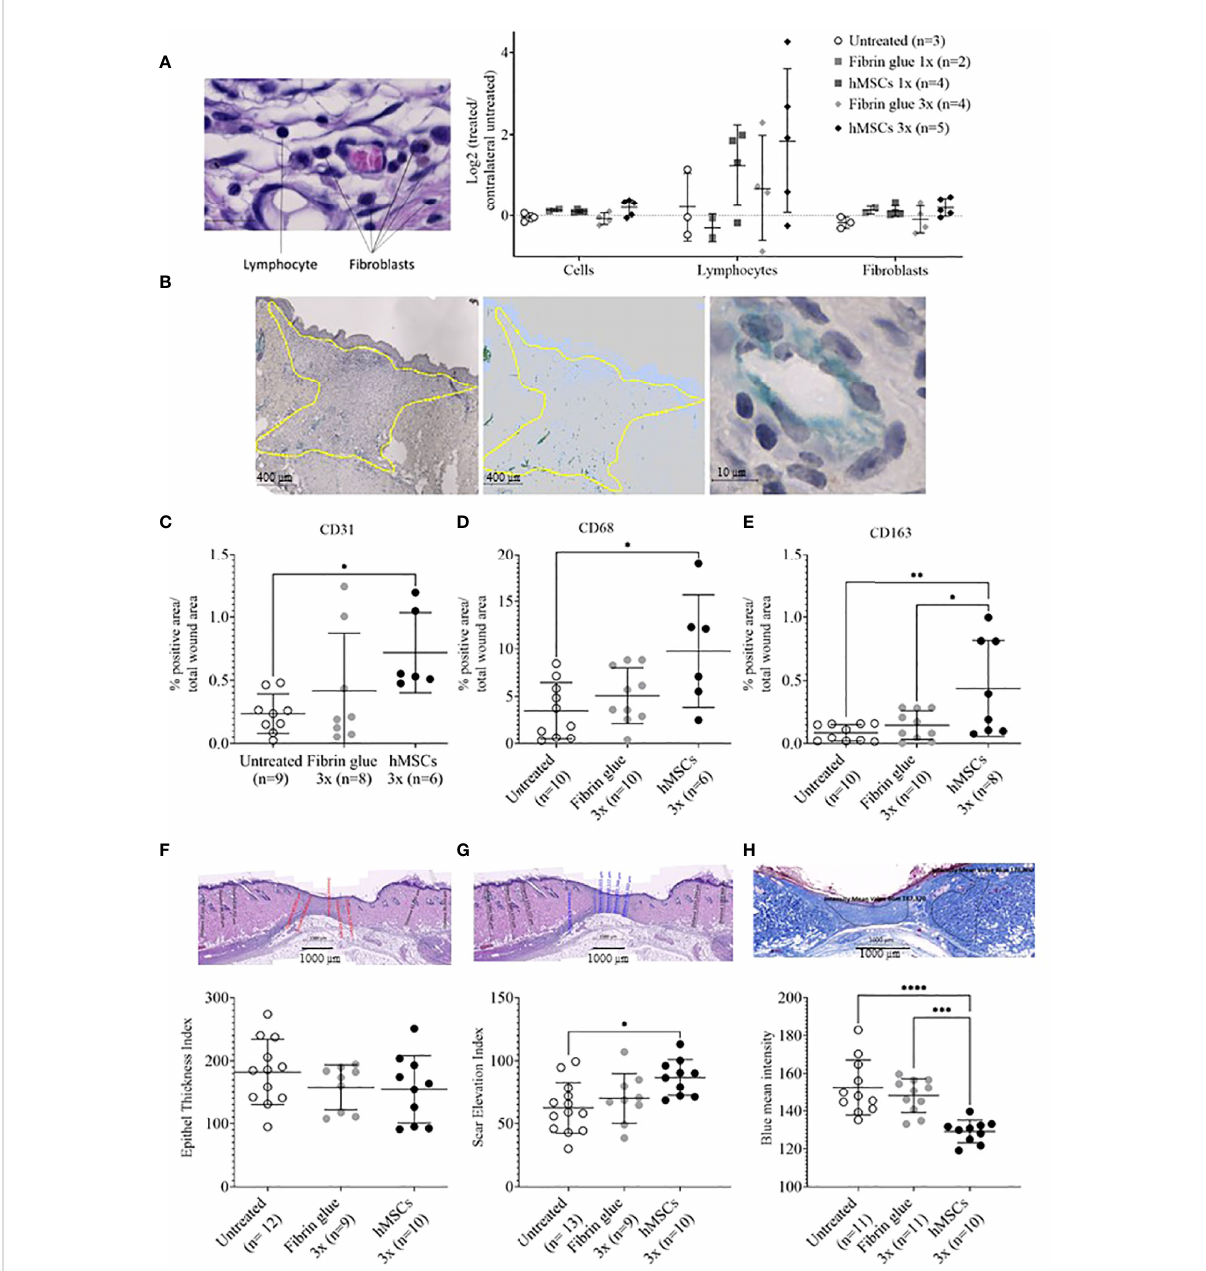
FIGURE 6 hMSCs tend to increase lymphocyte in fi ltration, CD31+ vascularization and CD68- and CD163-positive macrophage in fi ltration, and to improve wound healing indices. Wound skin was harvested at d14 and histologically analyzed. (A) Frequencies of total cells, lymphocytes and fi broblasts within wounds analyzed by QuPath algorithm on HE stains. Values were normalized against the untreated contralateral site. (B) Representative images of CD31-positive structures and calculation relative to the total wound area outlined in yellow. (C – E) Frequencies of (C) CD31+, (D) CD68+ and (E) CD163+ cells were determined by immunohistochemical staining relative to the total wound area. (F – H) Histological wound healing indices: (F) Epithelial thickness index (ETI) calculated by comparing epithelial thickness in the uninjured skin and wounded area, (G) scar elevation index (SEI) calculated by comparing the dermis thickness in the uninjured skin and wounded area and (H) collagen density after Azan staining in the uninjured skin and wounded area. Quanti fi cation was done using QuPath algorithms. Data from individual wounds are shown. *p ≤ 0.05, **p ≤ 0.01, ***p ≤ 0.001, **** p ≤ 0.0001, as calculated using one-way ANOVA und